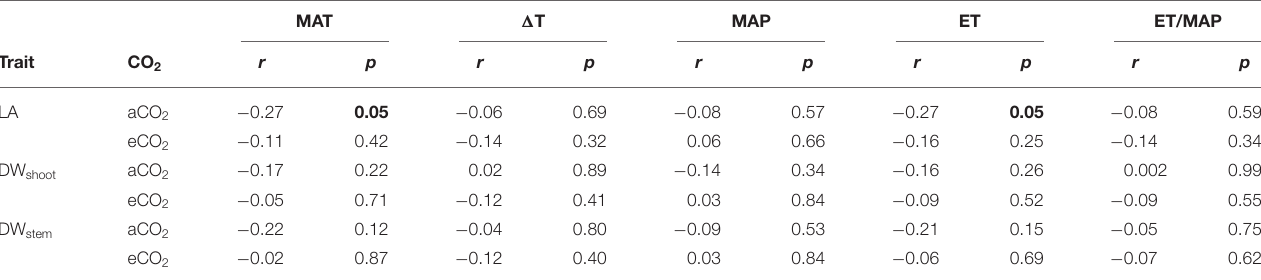
TABLE 6 | Pearson’s correlation coefficient ( Pearson’s r ) between leaf area (LA), shoot dry weight (DW shoot ) and stem dry weight (DW stem ), and climate variables of seed origin of the nine provenances selected for Experiment 2: mean annual temperature (MAT, ◦ C), difference between mean annual maximum and minimum temperature ( 1